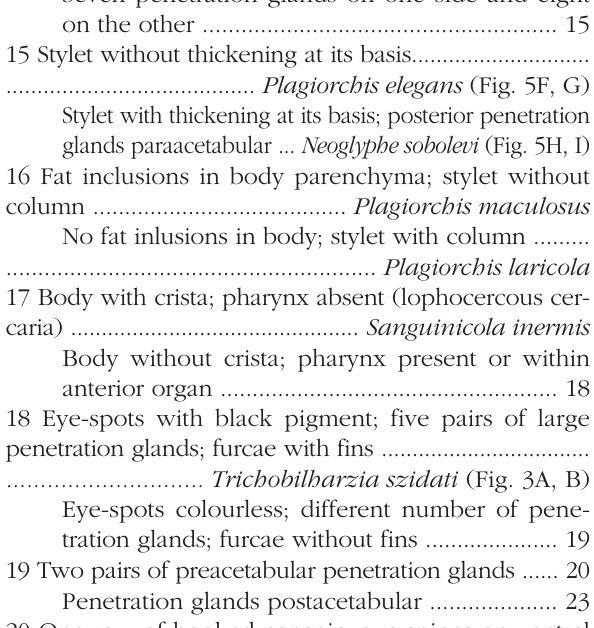
8 Cercaria large (500-700 µm), with one large dorso- ventral fin fold; tip of tail without contractile